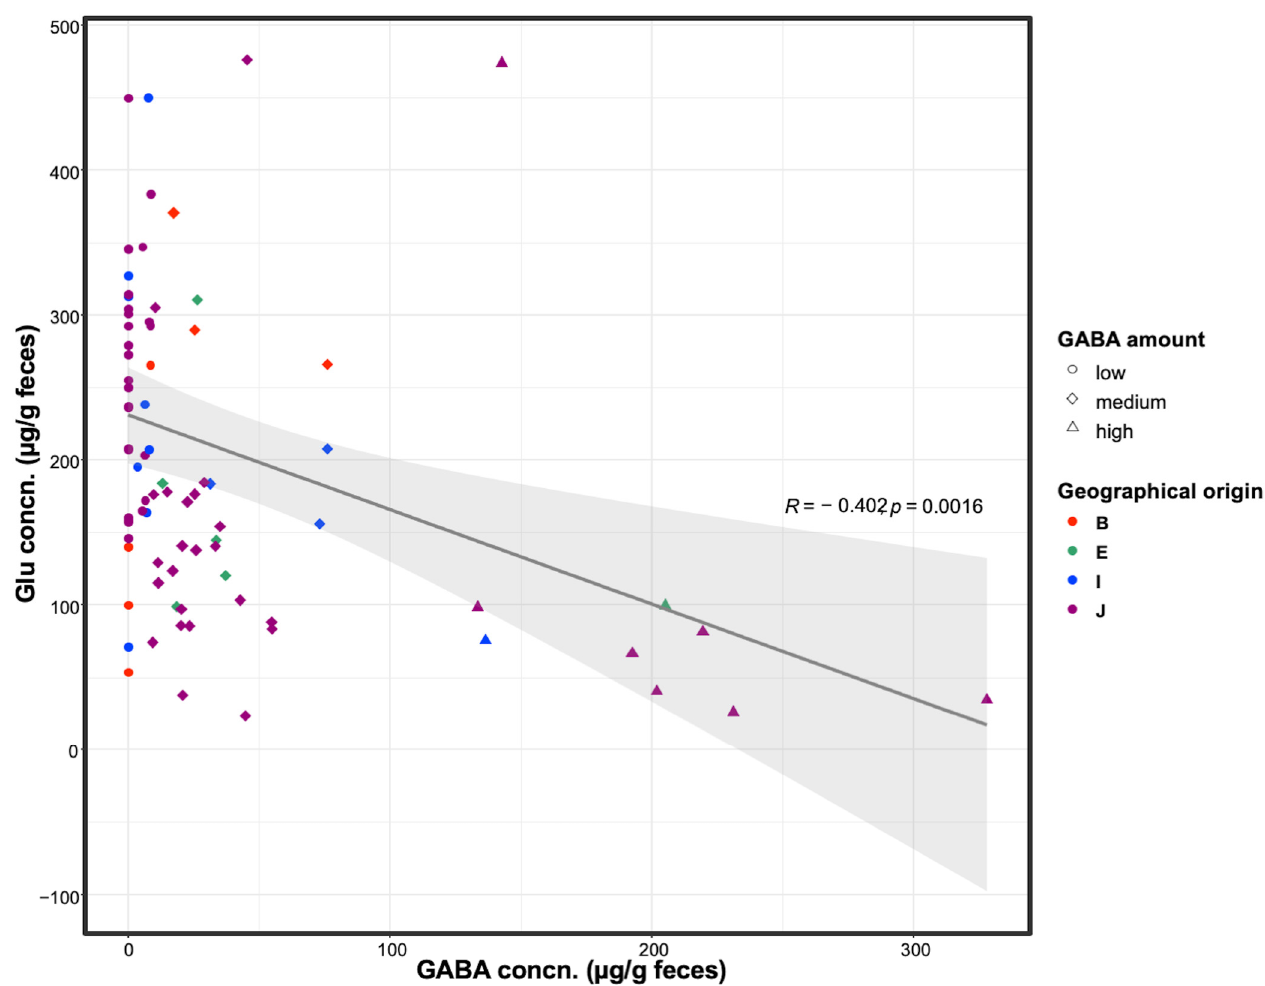
Figure 1. Fecal GABA and glutamate concentrations. Fecal GABA and glutamate contents were analyzed among healthy human participants. Participants were divided based on GABA productivity into high, medium, and low groups. Circle, diamond, and triangle symbols represent participants categorized as low-, medium-, and high-GABA productivity groups, respectively. Different colors represent the geographical origin of each participant: B, South Asia; E, Northeast Africa; I, Southeast Asia; J, East Asia. Regression curve is displayed on the figure with a deep gray line, showing a negative correlation between fecal GABA and glutamate concentrations. Confidence interval (95%) is expressed in a light gray color. The correlation coefficient (R) and p -value of the regression curve are also shown on the plot.